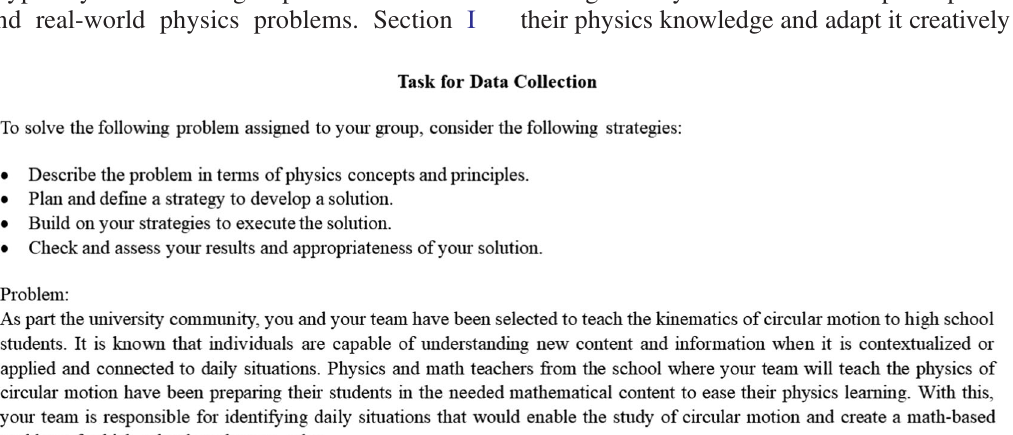
FIG. 1. Real-world physics problem administered to course